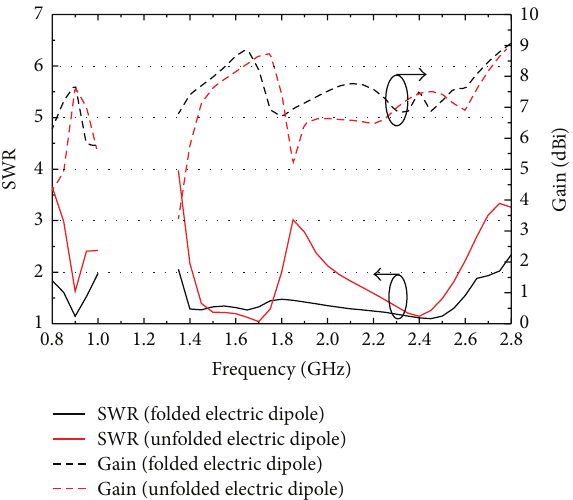
Figure 5: Effects of folded and unfolded electric dipoles.